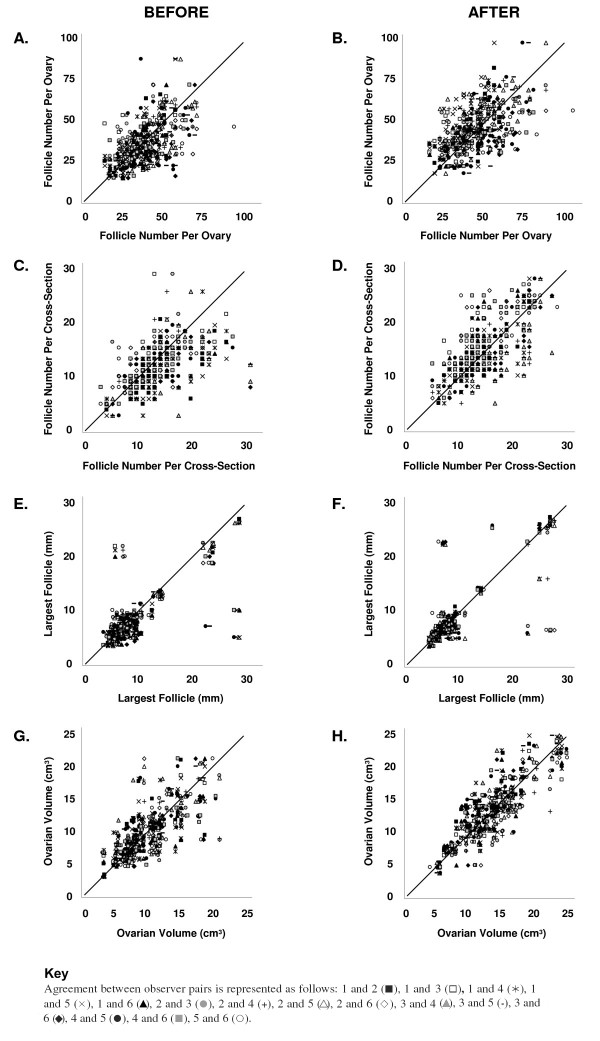
Scatter plots of follicle number per ovary counts (FNPO; A and B), follicle number per single cross-section counts (FNPS; C and D), largest follicle diameter measurements (E and F) and ovarian volume calculations (G and H) by all possible pair-wise combinations of the six observers before and after the ultrasound workshop are presented. Perfect agreement between two observers corresponds to a slope of 1 (diagonal line). Before the workshop, agreement was best for ovarian volume and largest follicle diameter and poorest for FNPO and FNPS. Following the workshop, visible improvement was apparent for FNPS, largest follicle diameter and ovarian volume. No improvement in FNPO was evident.